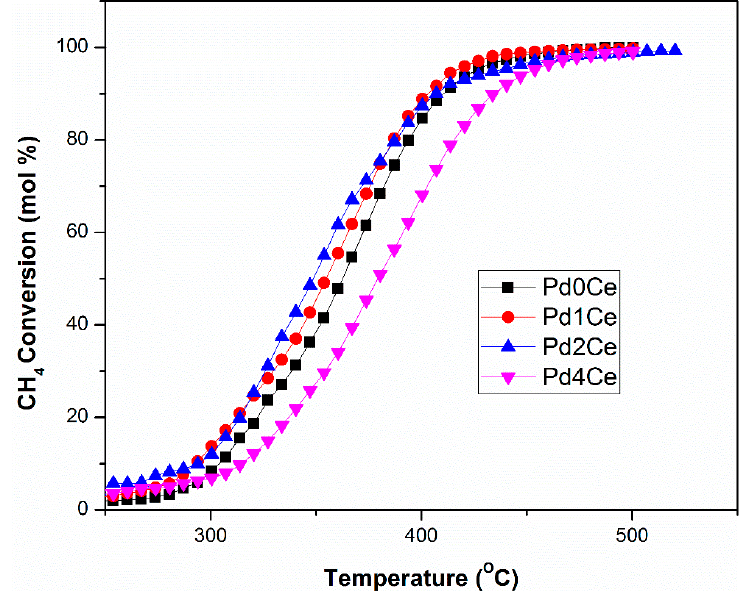
Figure 6. Temperature-programmed CH 4 oxidation profile: the initial activity of the catalysts as a function of temperature after the catalysts were regenerated. Reaction conditions: GHSV = 36,000 h − 1 , Feed gas composition: 0.07 vol.% CH 4 , 8.5 vol.% O 2 , 0.06 vol.% CO and 8 vol.% CO 2 in N 2 and He.